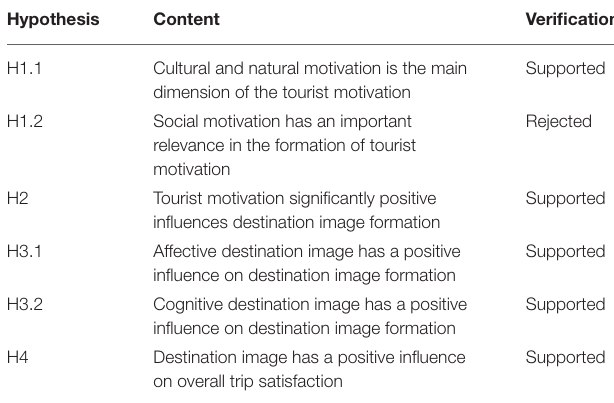
TABLE 9 | Significance of the coefficients.